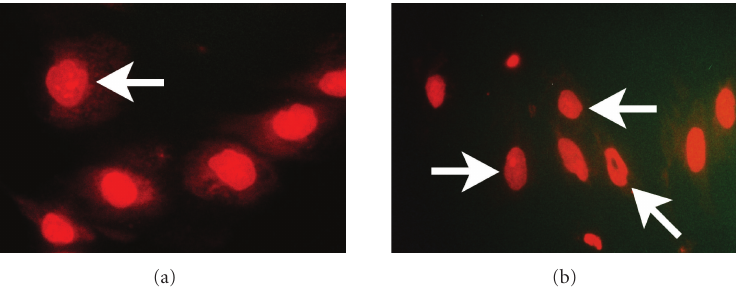
Figure 2: Nuclear changes in di ff erentiating MSCs after inhibition of protein farnesylation: cells were plated and induced to di ff erentiate as previously described. At week 2 of di ff erentiation, cells were fixed and stained using propidium iodide to identify nuclear changes (blebbing and vacuolization). The figure shows the changes in nuclear morphology compatible with blebbing (white arrows) in most of the cells after treatment with FTI-277 (5 μ M) (b). In contrast, untreated cells (a) showed fewer changes compatible with blebbing. Morphologically, cells treated with FTI-277 showed smaller nuclei than AIM-treated cells. Photomicrographs were taken at × 100 magnification and represent three di ff erent experiments.